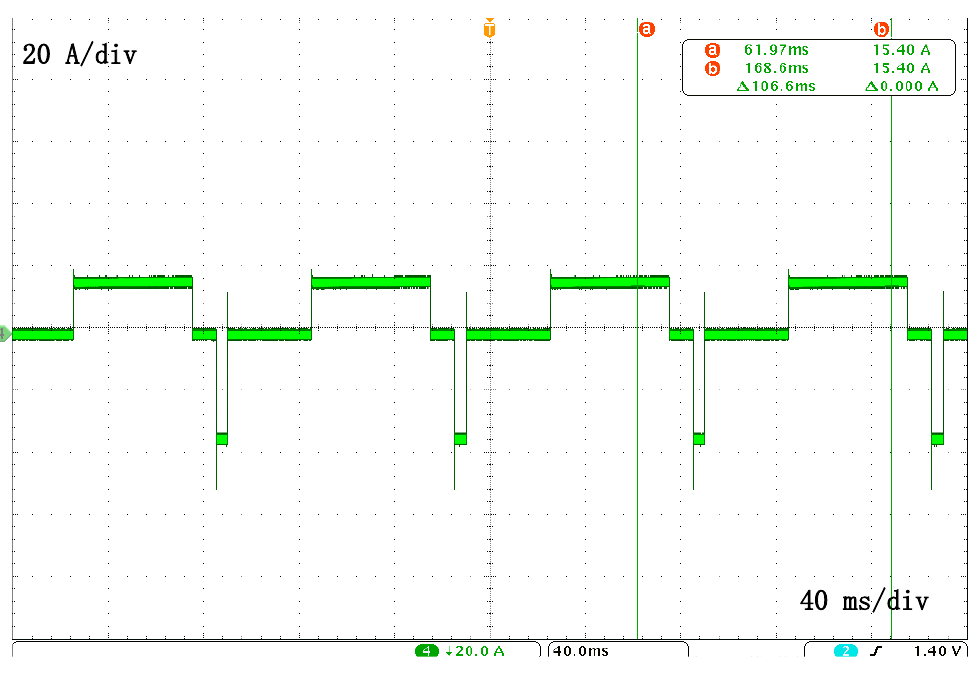
Figure 4. Bidirectional asymmetric pulse current waveform.